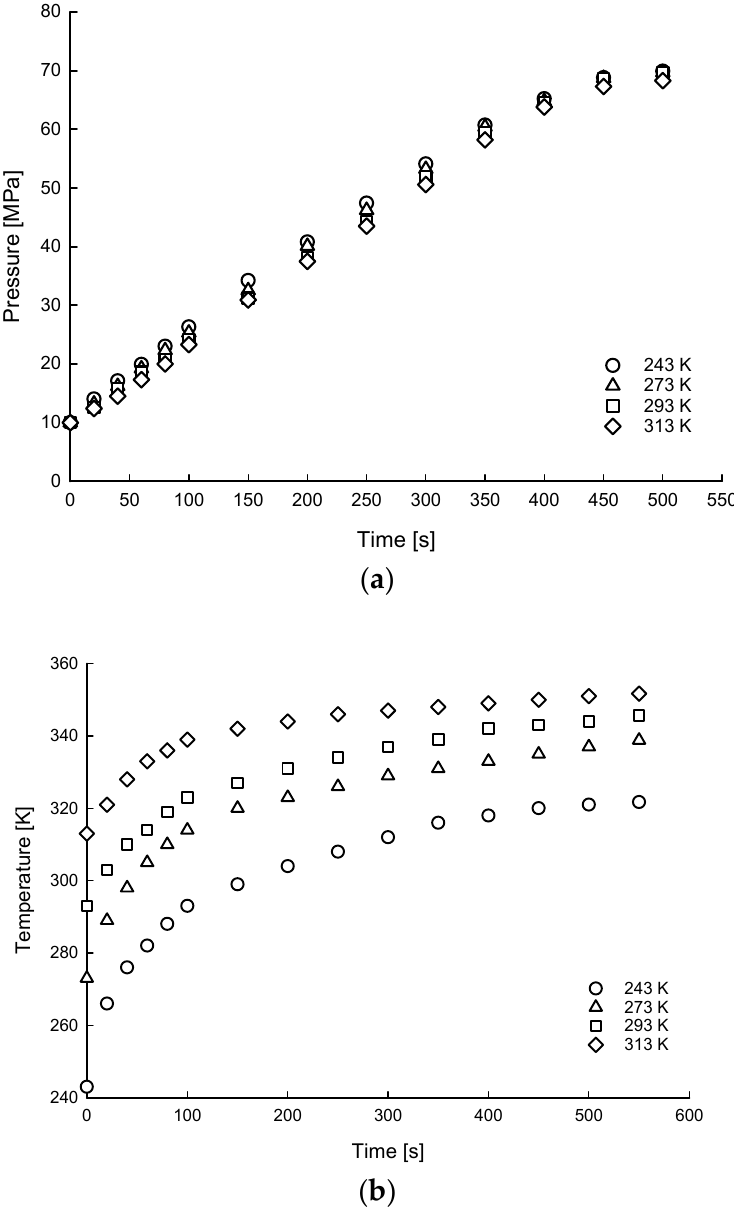
Figure 6. Time histories of hydrogen of average gas pressure ( a ) and temperature ( b ) distributions of filling process for 10 MPa SOC pressure condition under different ambient temperature condi- tions.